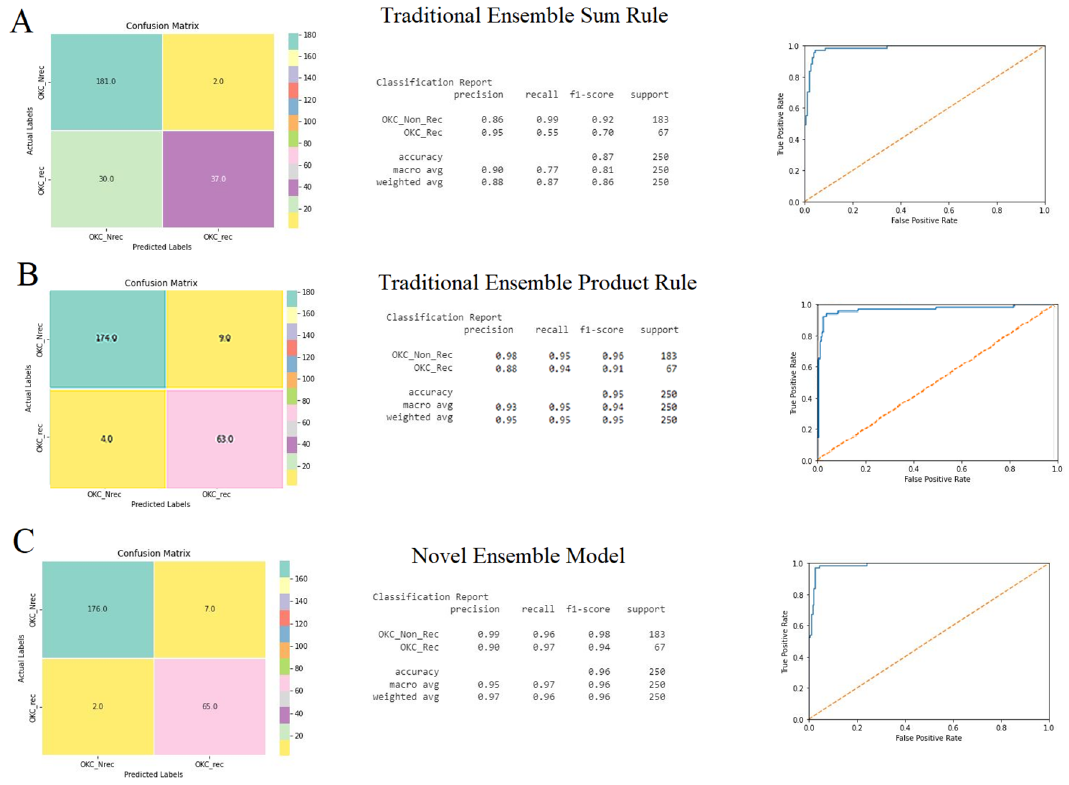
Figure 5. Performances of the ensemble models: ( A ) traditional ensemble sum rule, ( B ) traditional ensemble product rule, and ( C ) novel ensemble model was demonstrated using confusion matrix, classification report for accuracy, and area under ROC